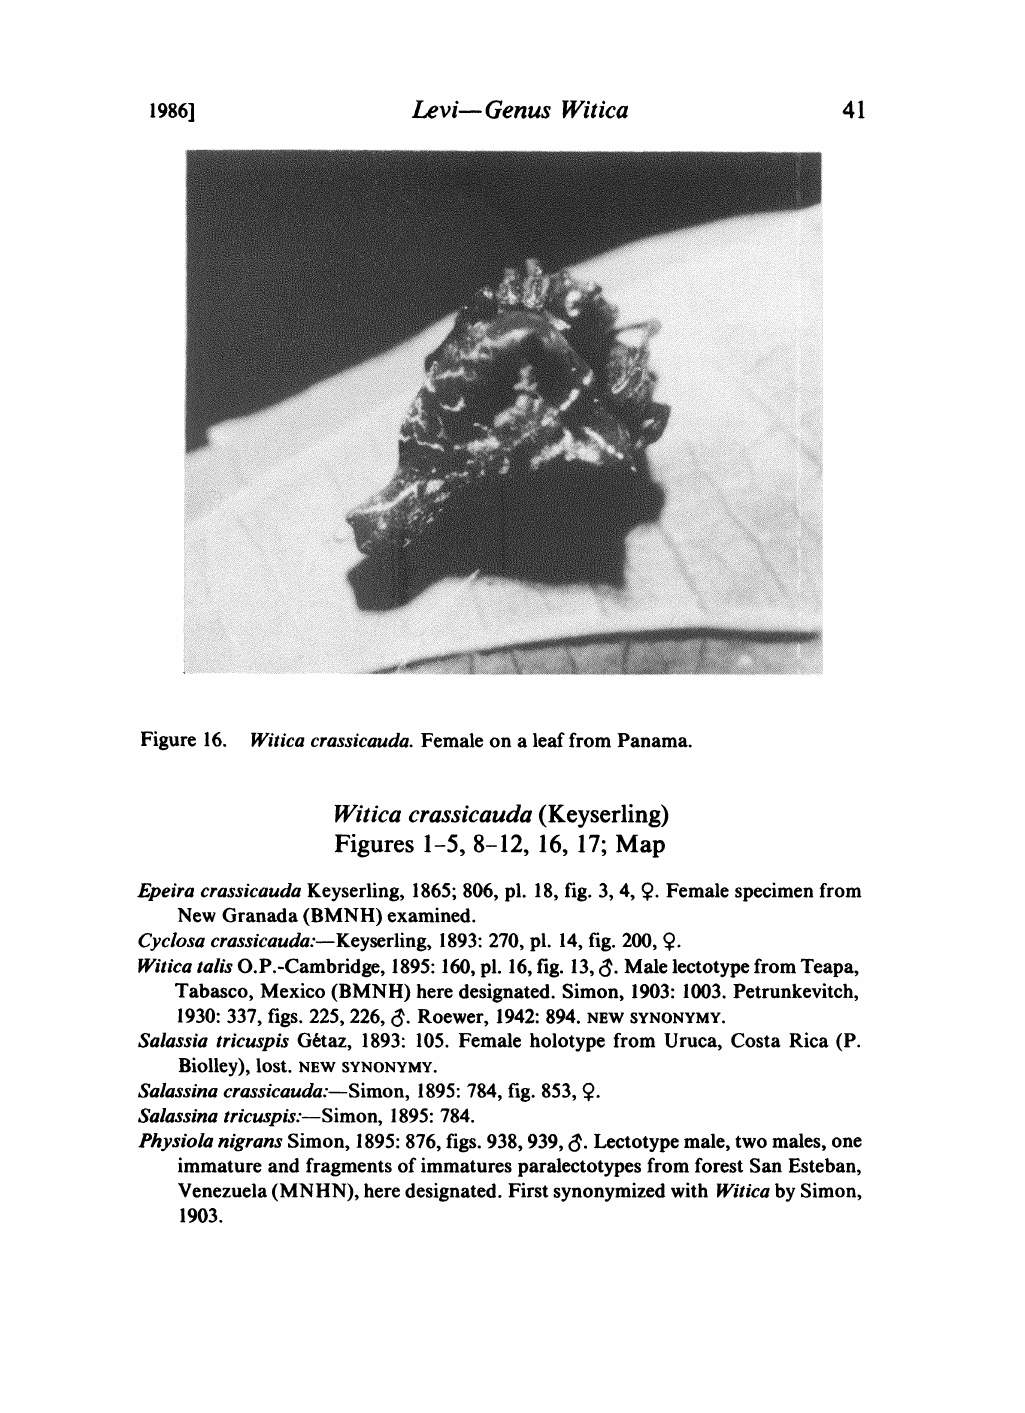
Figure 16. Witica crassicauda. Female on a leaf from